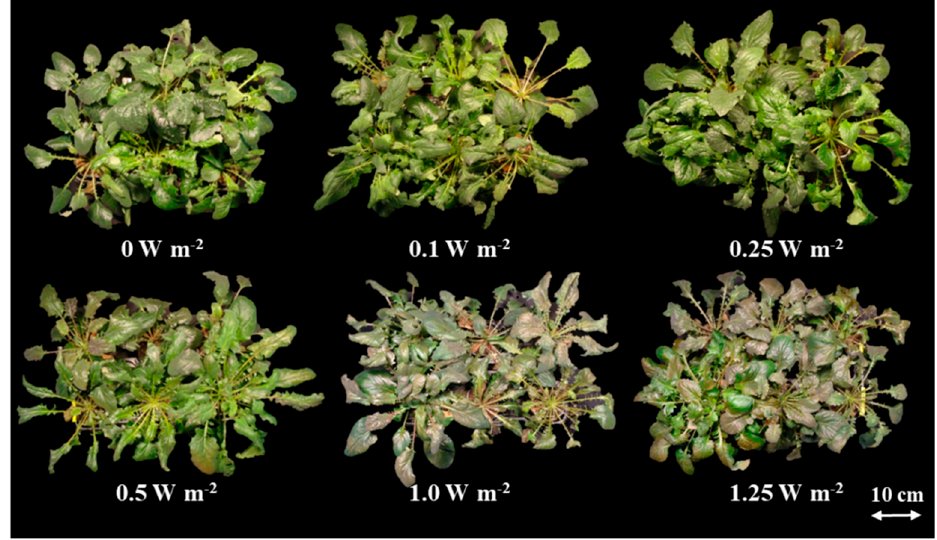
Figure 2. C. denticulatum subjected to five energy levels of UV-B radiation at 6 days after treatment. The UV-B treatments started after 5 weeks of transplanting.